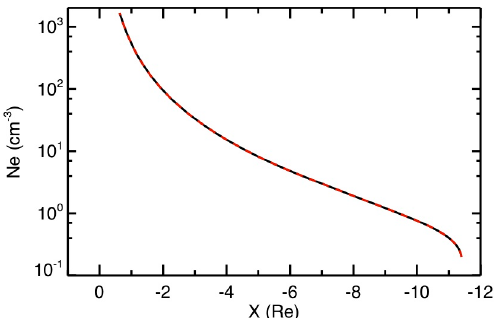
Fig. 6b. (b) shows the ion number density ( ∼ electron number den- sity) along the Alfv´en travel path estimated under the assumptions discussed in Sect. 5. The dashed red curve is for the E-1 event, the solid black curve is for the E-2 event.